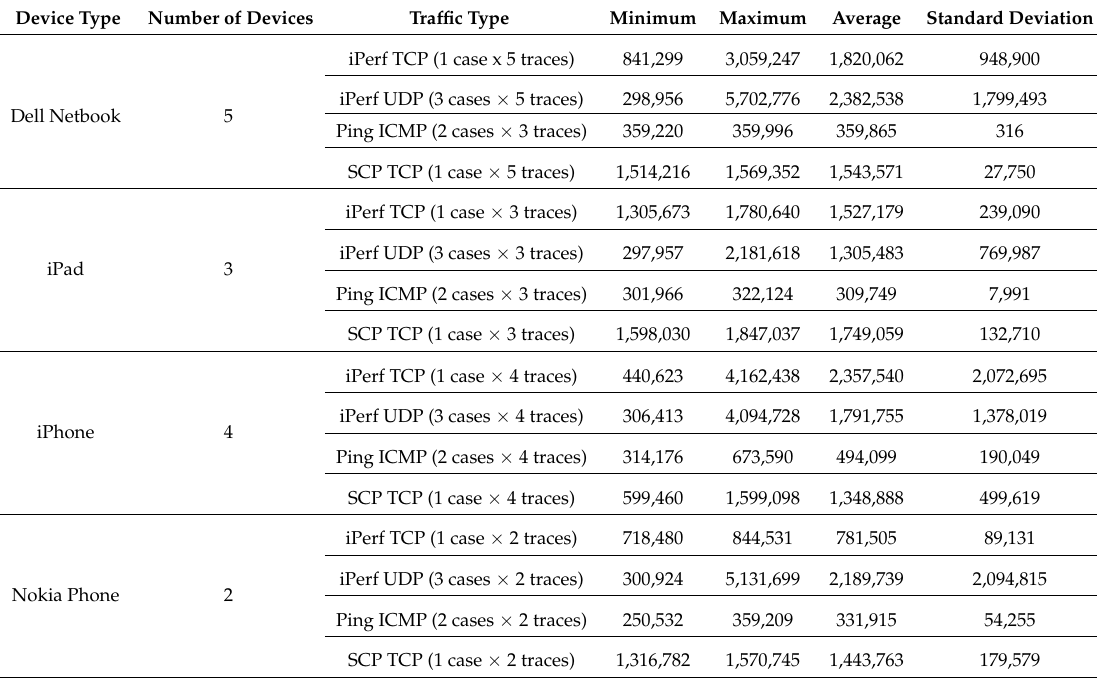
Table 3. Isolated testbed data summary describing (i) the device types; (ii) the number of devices for each of these types; (iii) the traffic type and number of data traces for each traffic type and (iv) minimum, maximum, average and standard deviation of the number of data points per data